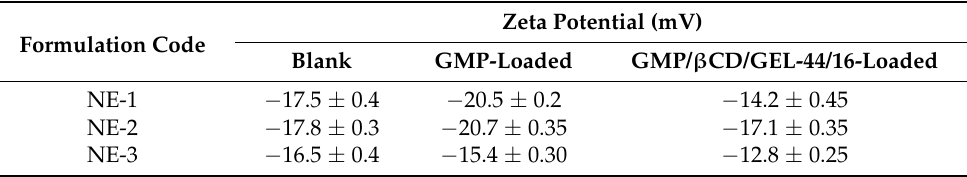
Table 3. Zeta potential analysis of blank (B), glimepiride-loaded (GMP), and inclusion complex loaded- (IC) nanoemulsions (Mean ± SD, n =